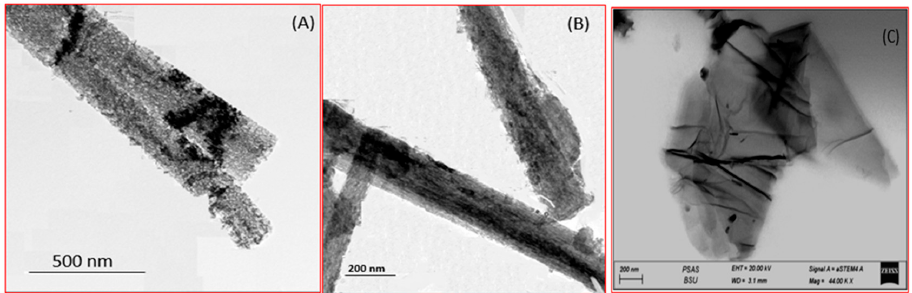
Figure 3. TEM image of ( A , B ) TNR and ( C ) GO nanomaterials.